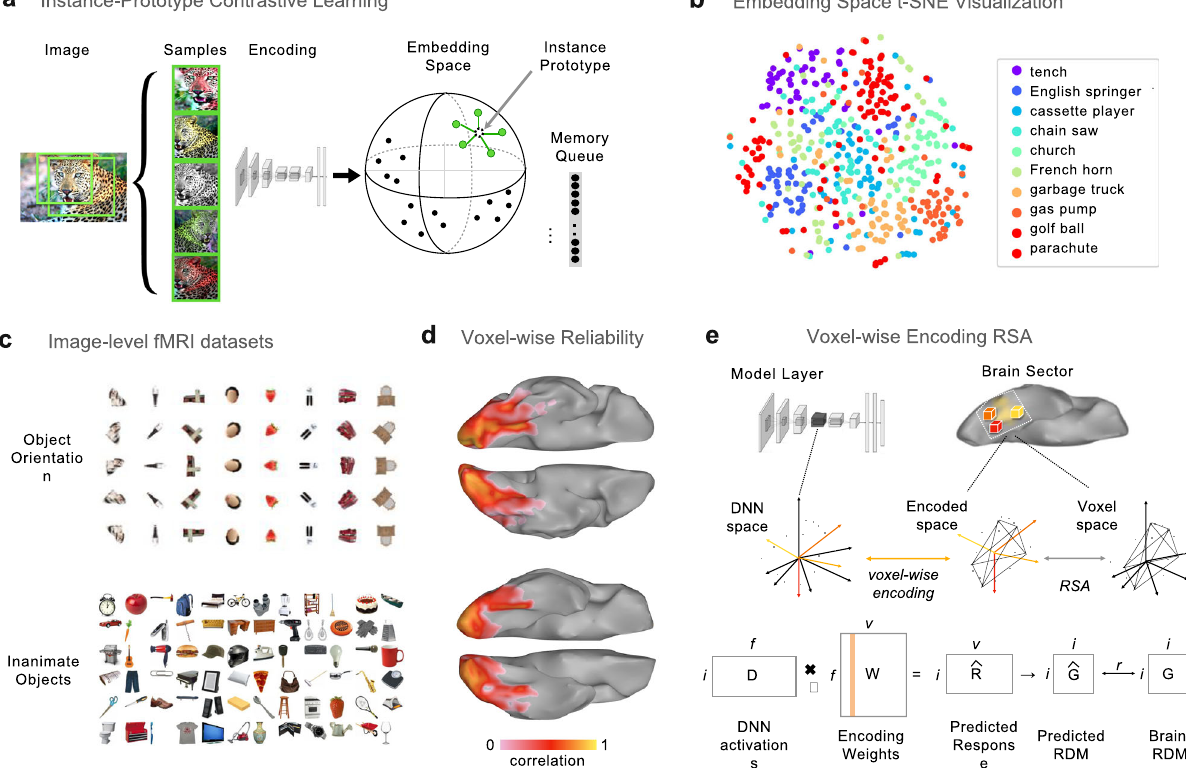
Fig. 1 Model overview and methodological approach. a Overview of the self-supervised instance-prototype contrastive learning (IPCL) model which learns instance-level representations without category or instance labels. b t-SNE visualization of 500 images from ten ImageNet categories, showing emergent category clusters in deepnet feature space. c All stimuli for the two fMRI datasets. Note that in this fi gure, the face image has been covered, to remove identifying information. d View from the bottom of the brain, showing voxel-wise reliability across the ventral visual stream for the Object Orientation dataset (top) and Inanimate Objects dataset (bottom). The color bar indicates the Pearson correlation between odd and even halves of the data. e Overview of the voxel-wise encoding RSA procedure. Source data are provided as a Source Data fi